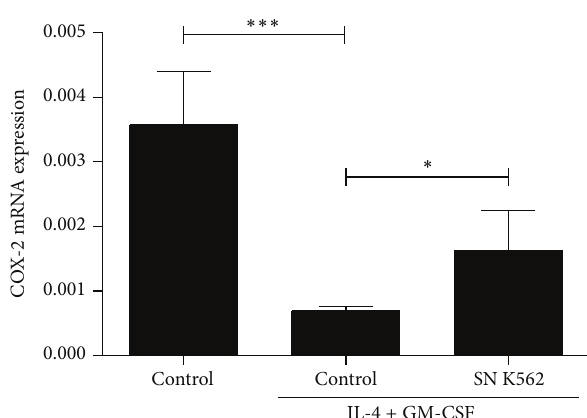
Figure 1: mRNA expression of COX-2 by monocytes differentiated with leukemic cell products. Mononuclear cells were obtained after gradient density from buffy coats of healthy individuals. After 2 h of adhesion, lymphocytes were removed and monocyte cultures were stimulated with IL-4 and GM-CSF (50 ng/mL) to induce dendritic cell differentiation. K562 supernatants (SN K562) were obtained after 3 days of cell culture in RPMI plus 10% of fetal bovine serum (FBS) followed by filtering (0.22 𝜇 m). 10% of SN K562 was used since the beginning of monocyte culture until the end (5 days). Afterward,totalmRNAwascollectedusingtrizol,retrotranscription was performed, and, finally, qPCR was done using COX-2 specific primers. The graph shows mean ± SEM of expression of COX-2 mRNA. ∗ 𝑝 ≤ 0.05 ; ∗∗∗ 𝑝 ≤ 0.001 . 𝑛 = 5